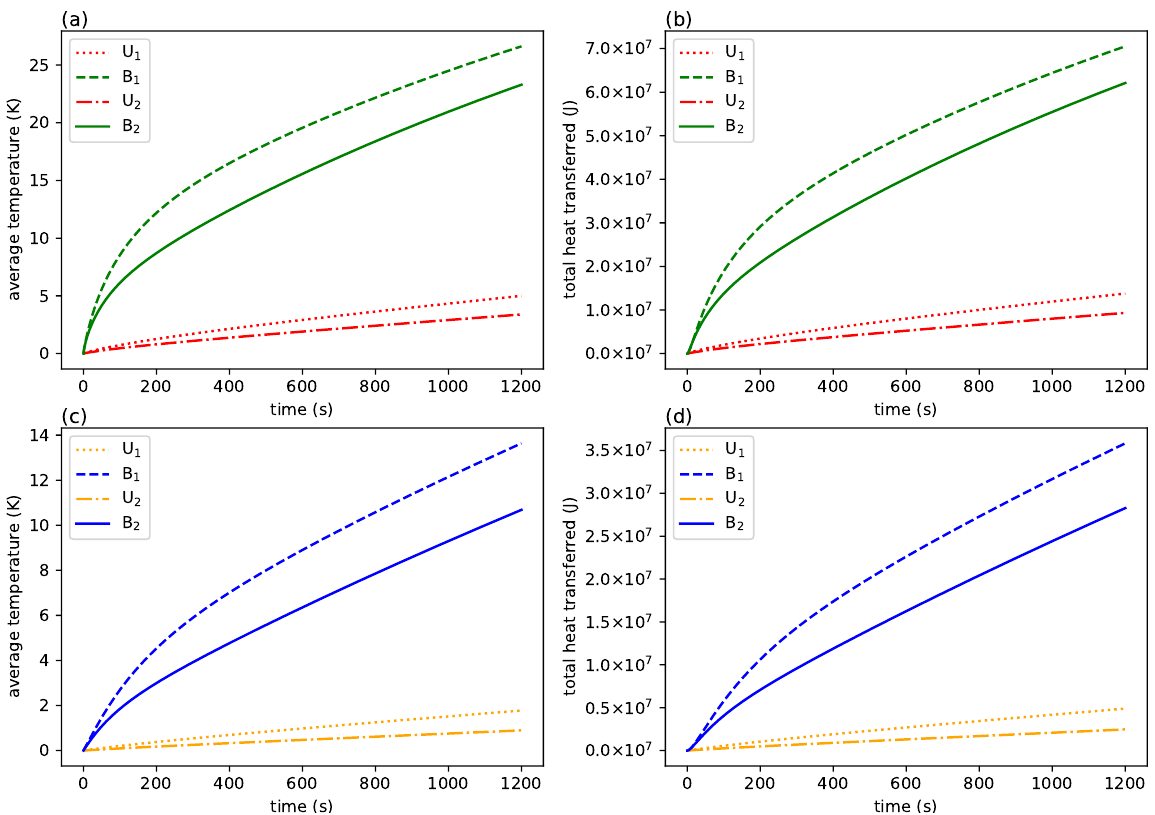
Figure 12. Comparison of numerical simulation results of uniform design and bionic design. ( a , b ) ∆ T ave and Q c of WC 1 ; ( c , d ) ∆ T ave and Q c of WC 2 . Table 3. The value of ∆ T ave and Q c of both designs under 2 working